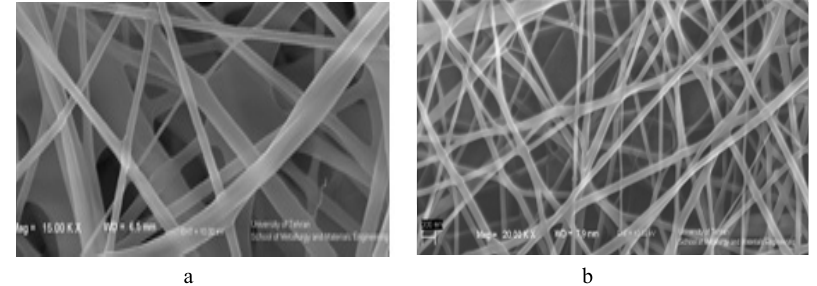
Fig. 4. SEM images of primary nanofibers containing 0.4%wt tetracycline (a) and nanofibers after immersion in acetate buffer for 24 hours at 37°C (b)